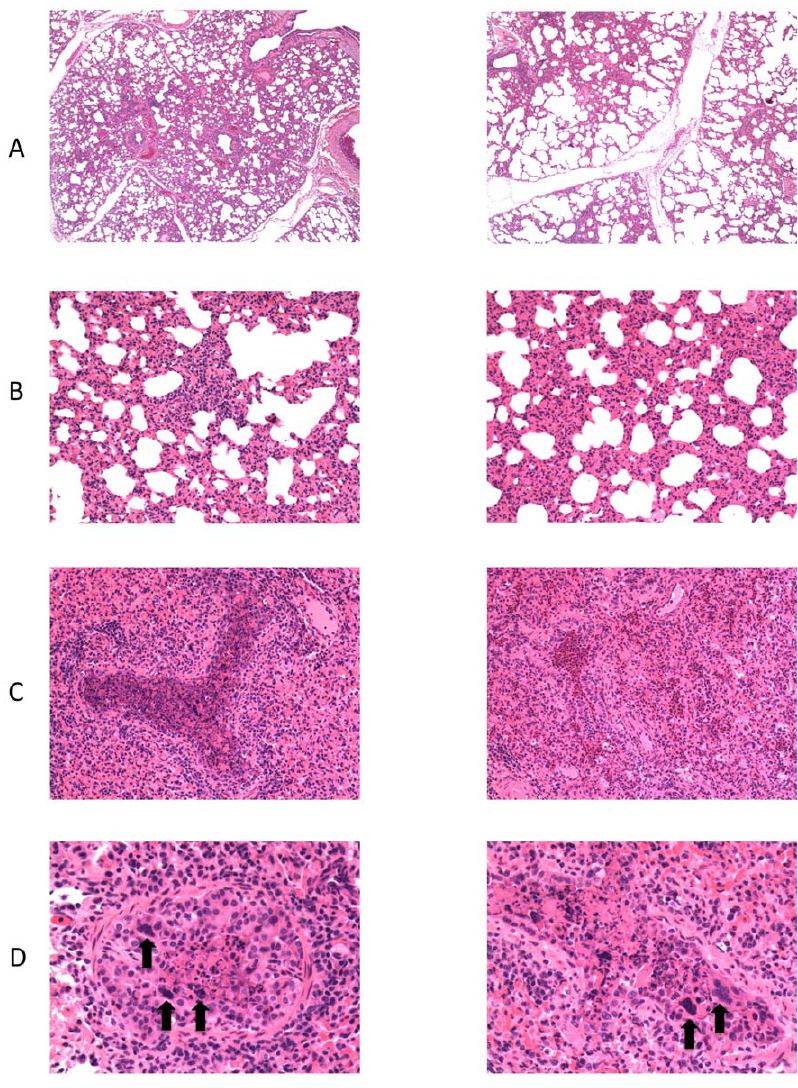
Figure 3. Histological lesions observed in lung of high and low vitamin D treatment groups of calves after experimental infection with bovine RSV. Calves with low or high circulating 25(OH)D 3 were challenged via aerosol with bovine RSV. On day 7 post-infection, samples of lung were collected for histological evaluation. A representative image from a single calf for each treatment group (low vitD left panels; high vitD right panels) is shown. ( A ) Moderate interstitial thickening and wide interlobular septae due to edema. Original magnification, 4 6 . ( B ) Alveolar septae are thickened due to cellular infiltrates found to be macrophages, lymphocytes and lesser numbers of neutrophils when viewed at higher magnification. Original magnification, 20 6 . ( C ) Bronchioles are filled with neutrophils, sloughed epithelial cells, and necrotic cell debris. Original magnification, 20 6 . ( D ) There is partial to complete loss of bronchiolar epithelial cells with attenuation of remaining cells. In some bronchioles, epithelial cells form multinucleated syncytial cells (arrows). Original magnification, 40 6